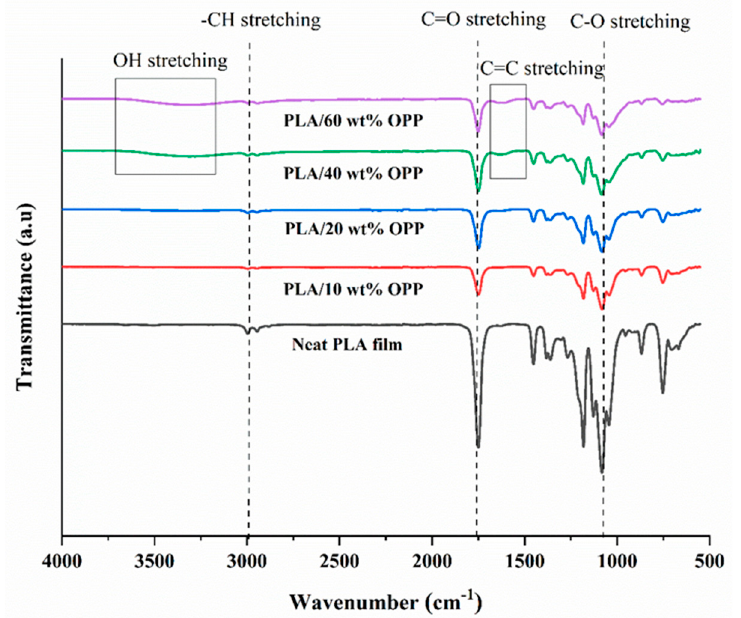
Figure 2. FTIR spectra of samples.